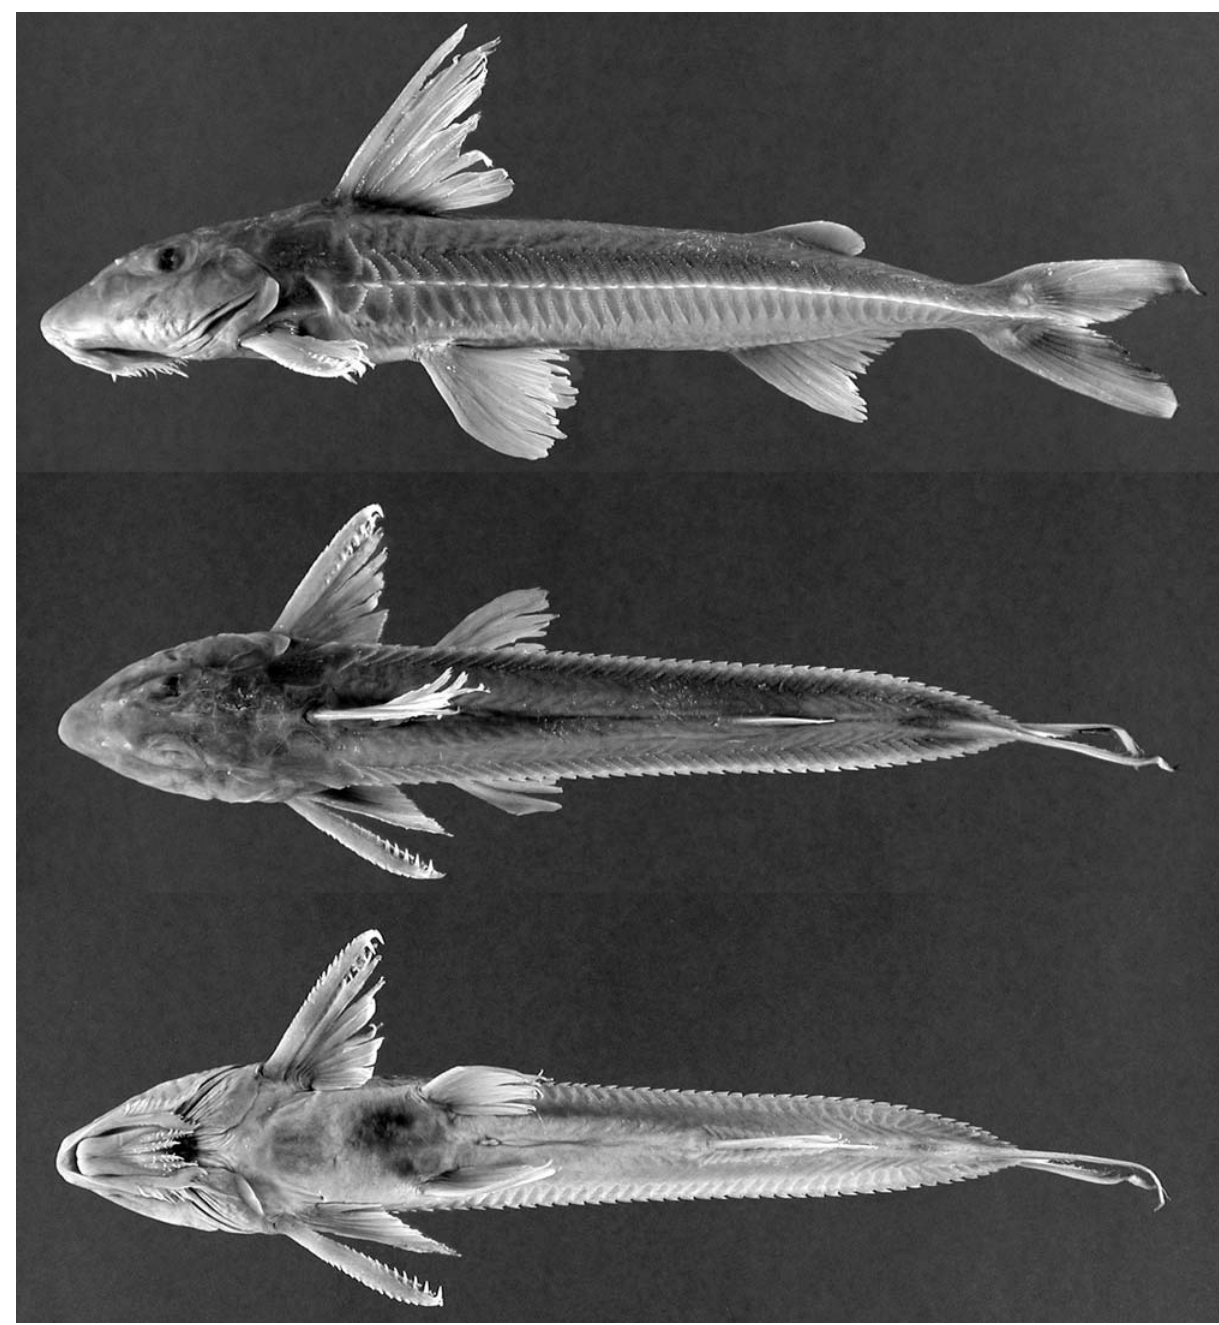
Fig. 22. Leptodoras cataniai , holotype, ANSP 180918 (SL 171 mm), río Casiquiare (Negro dr.) from mouth of rio Pamoni to 4 km below mouth, Amazonas,